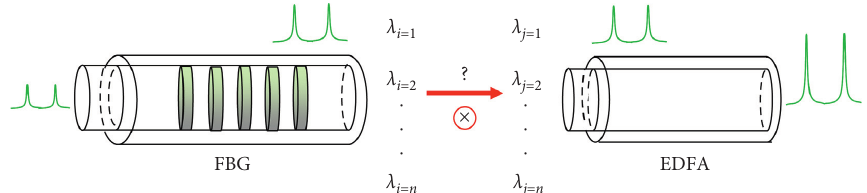
Figure 2: Optical transmission system